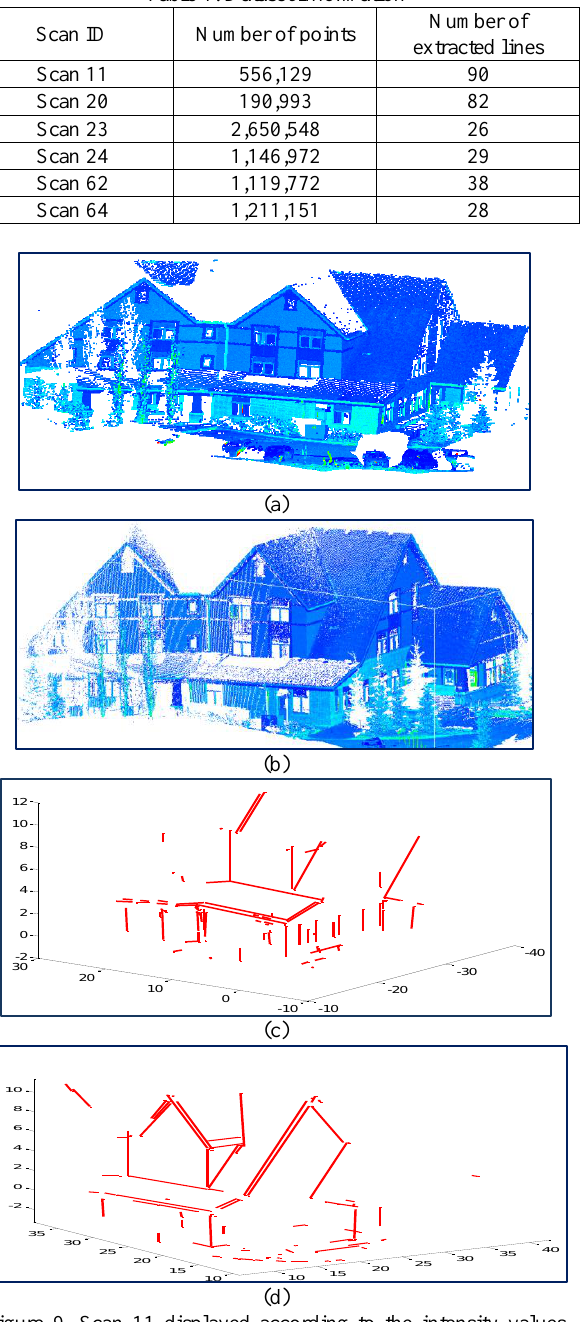
Table 1. Dataset Information